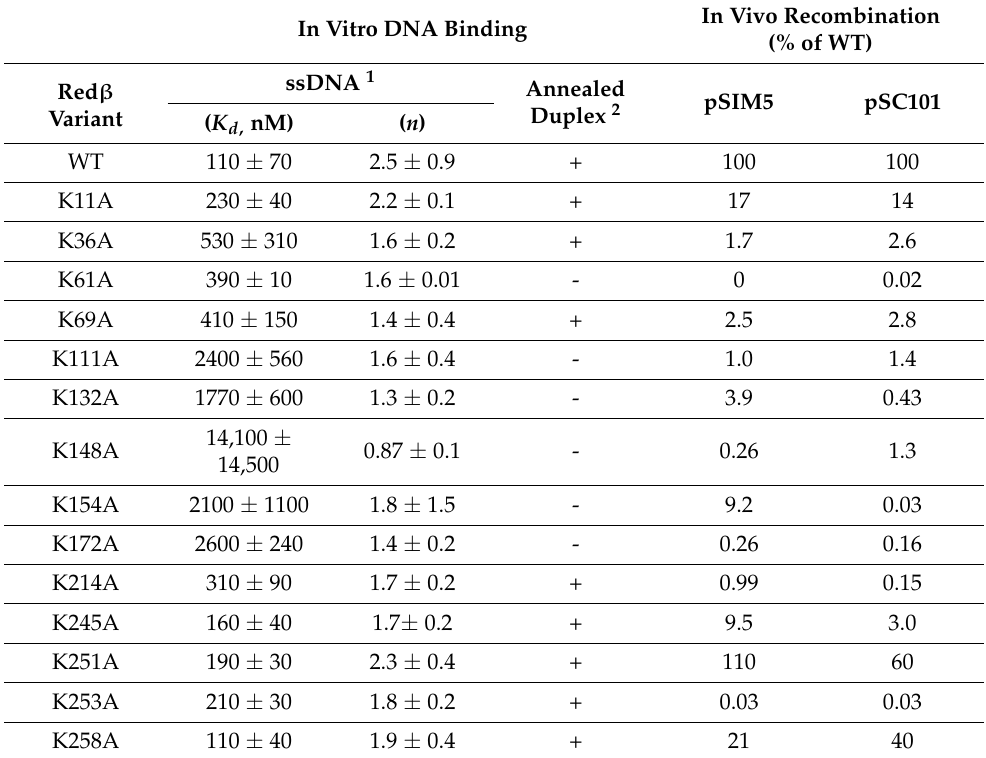
In Vivo Recombination (% of WT)